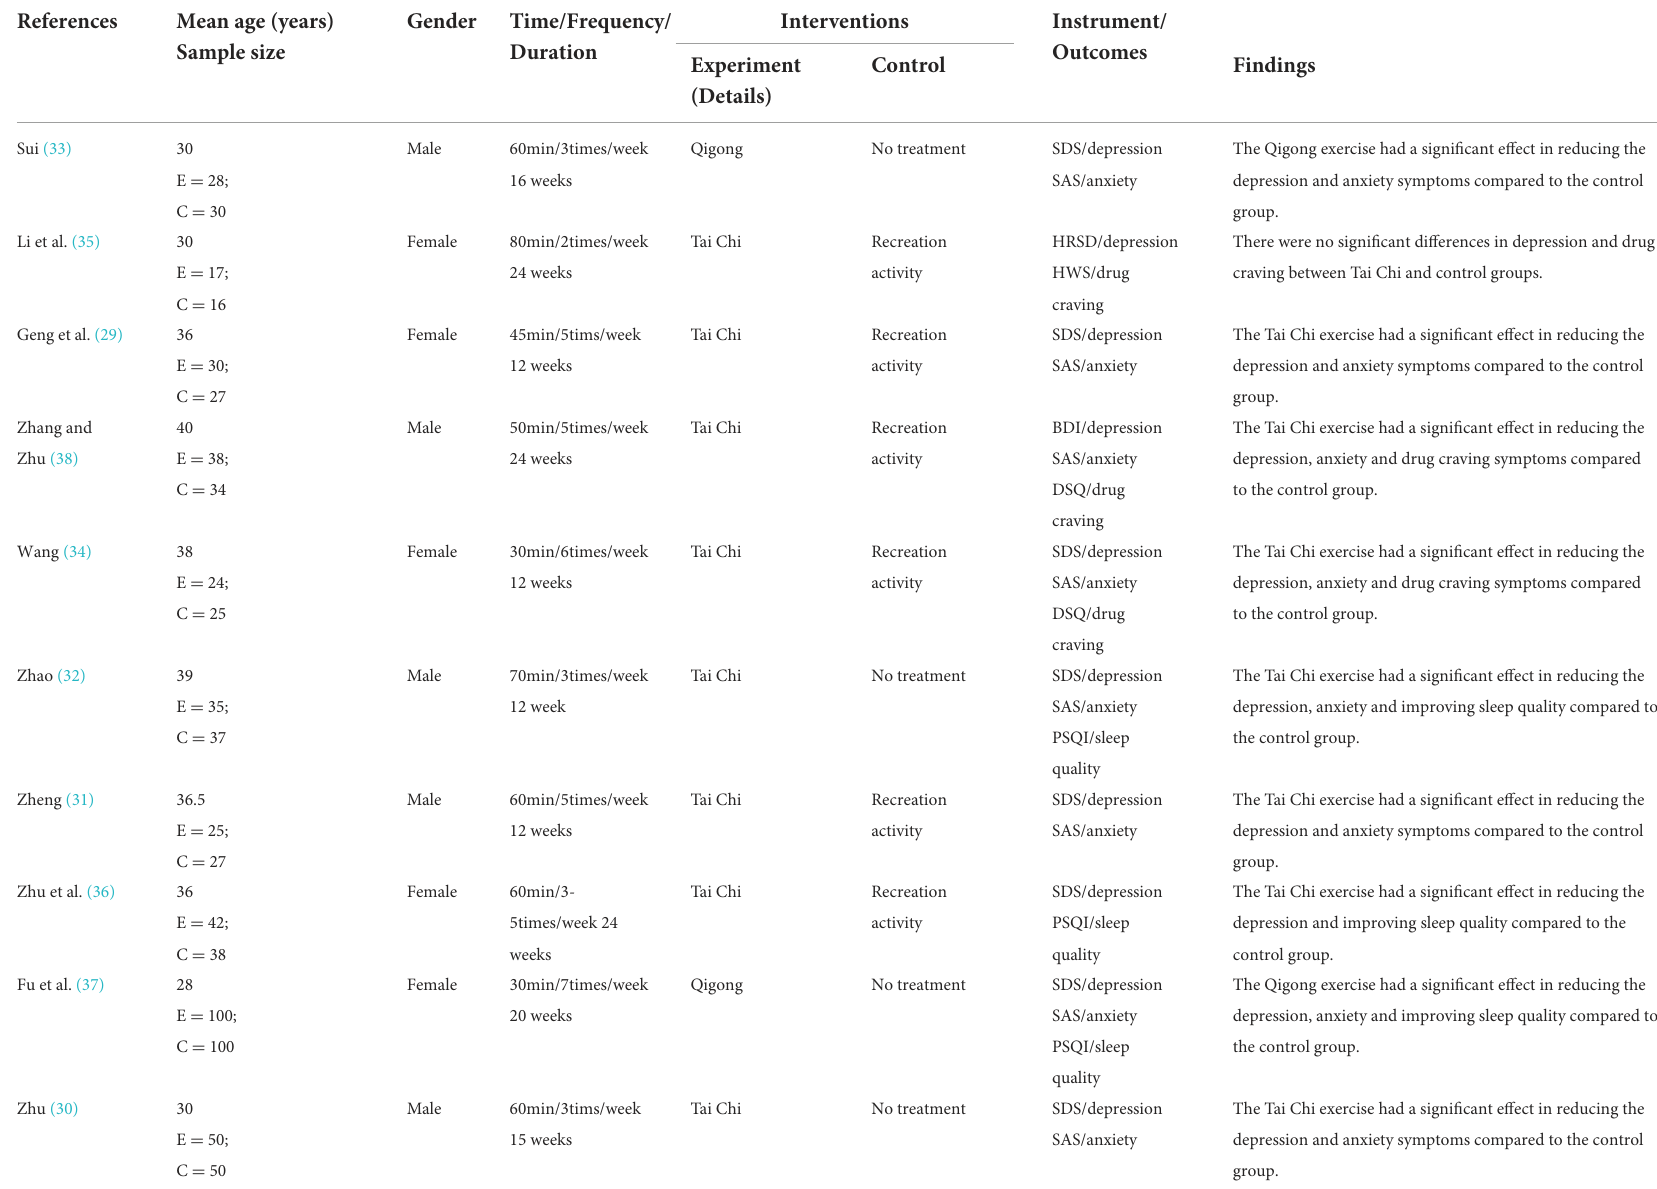
TABLE 1 Characteristics of the included